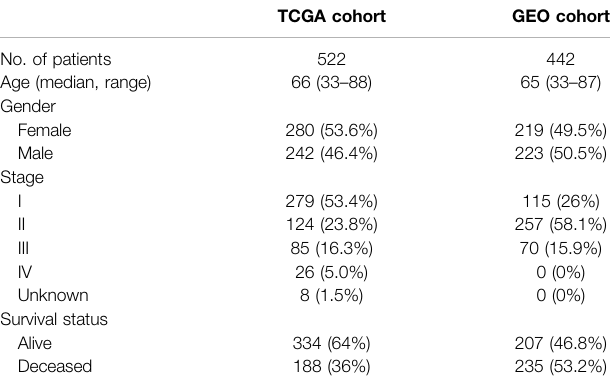
TABLE 1 | Clinical characteristics of the LUAD patients used in this study.